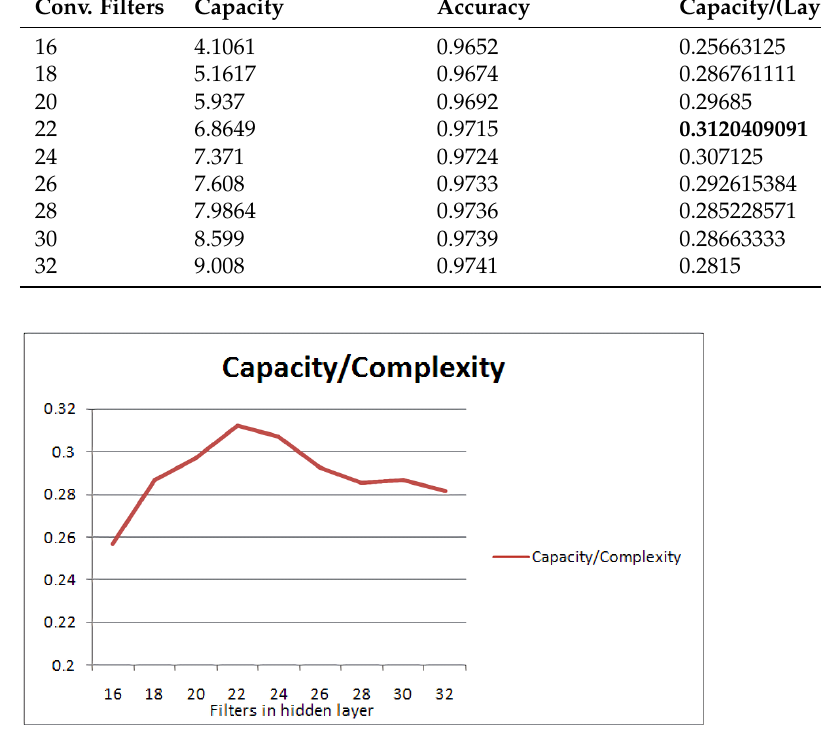
Figure 4. Estimating the Capacity/Layer Complexity ratio for a varying number of filters in the hidden layer of a 1-layer convolutive NN. The configuration of 22 filters seems to yield the optimal ratio for the MNIST